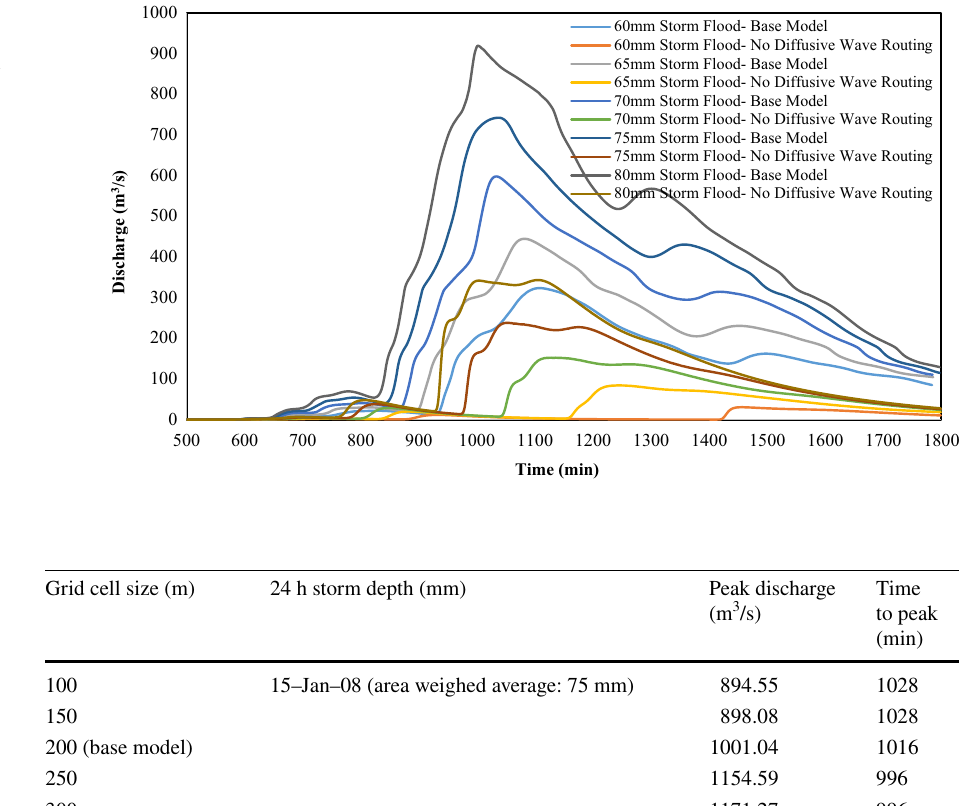
Fig. 17 Flood hydrographs of calibrated GSSHA base model for six 24 h floods of 60–80 mm cumulative depths compared to hydrographs corresponding to GSSHA model by no diffusive wave simulation